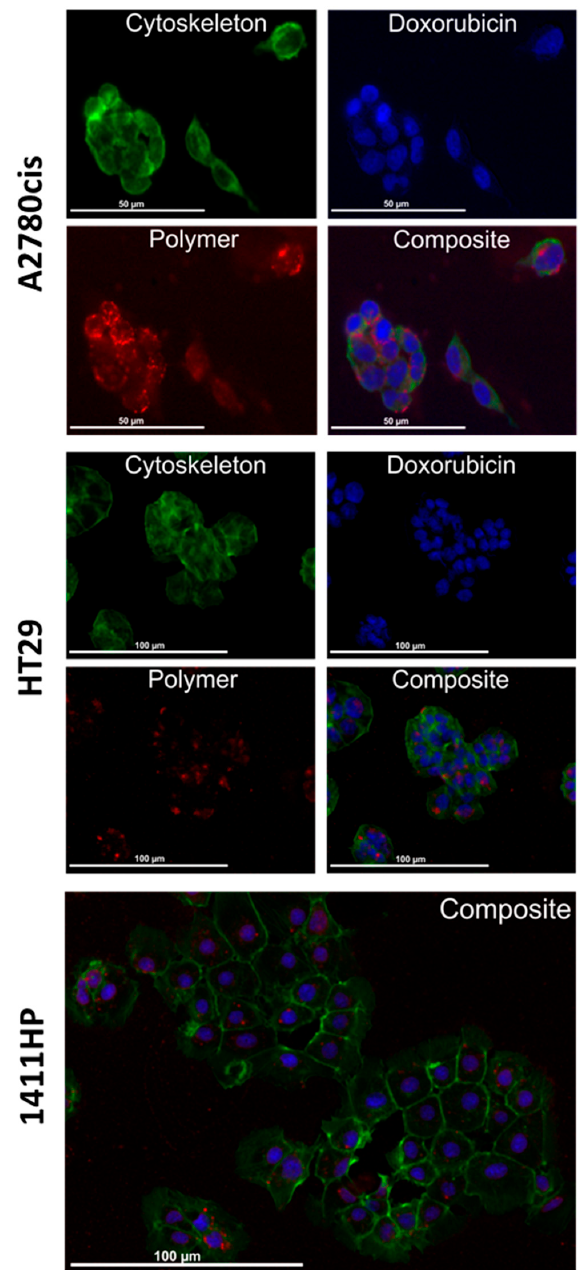
Figure 4. Cellular uptake, distribution and drug release of pHPMA-Dox-Cy7 on cell monolayers. The cells were treated for 8 h and analyzed by multispectral fluorescence imaging, allowing simultaneous visualization of polymer carrier (red), Dox (blue) and cytoskeleton (green) followed by creation of composite